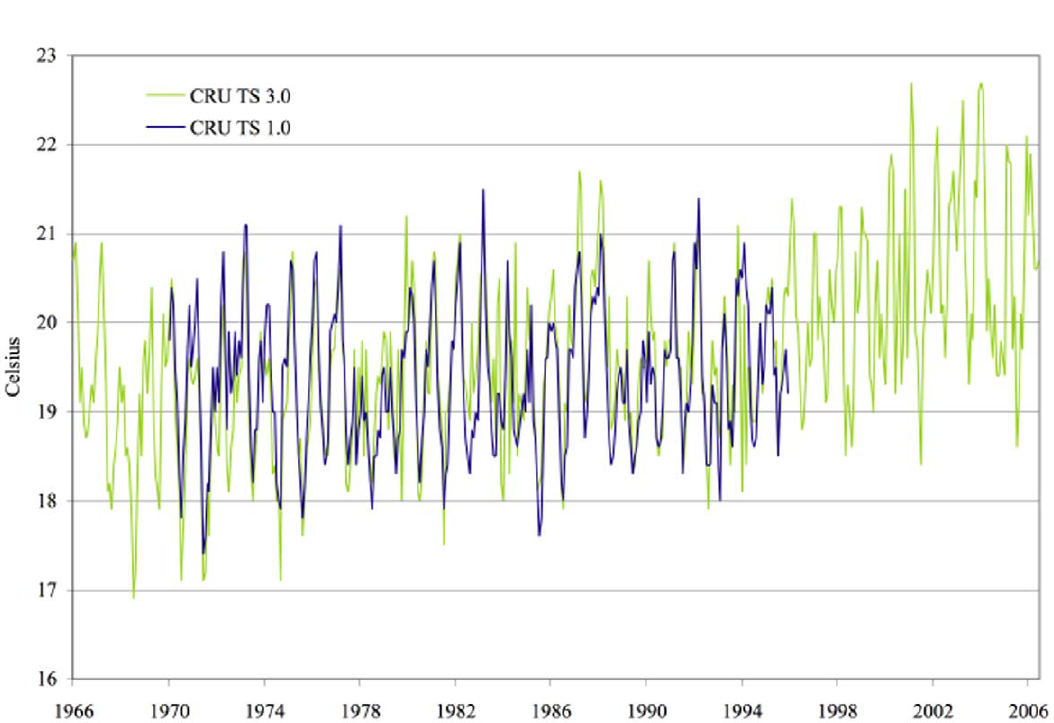
Figure 3. Temperature series for Kericho: CRU TS 1.0 vs. CRU TS 3.0.